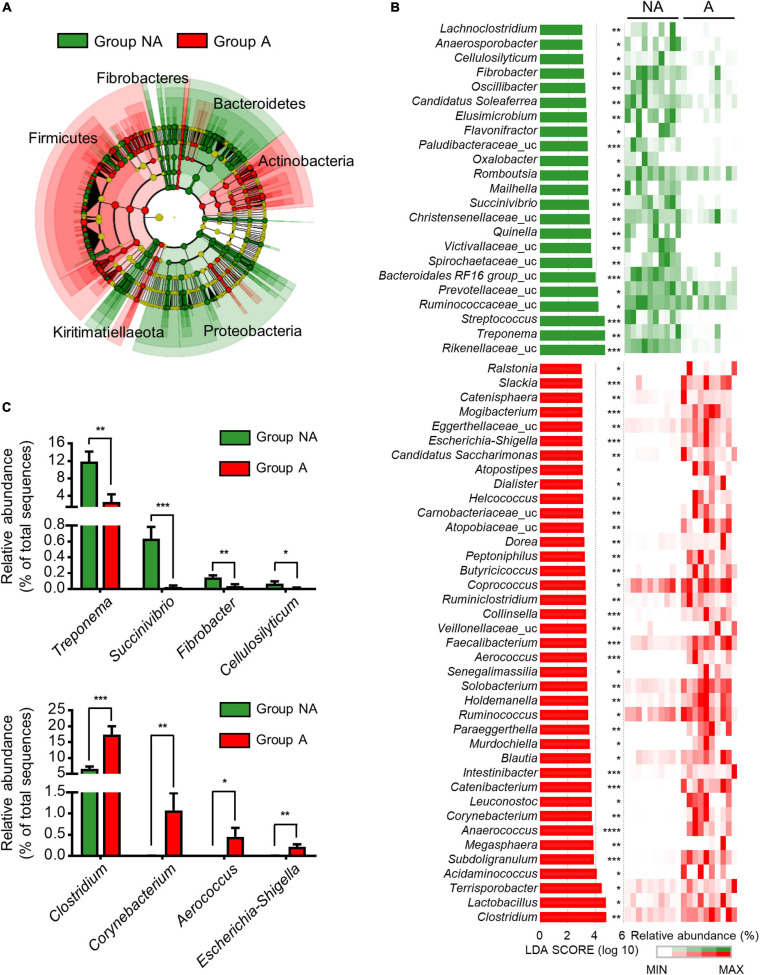
Comparison of swine microbial communities between the two groups. (A) Phylogenetic cladogram from LEfSe analysis, depicting the taxonomic association between the microbiome communities of groups NA and A. Each node represents a specific taxonomic type. (B) The ranking of significantly different genera by LEfSe method was revealed from the log LDA scores of the two groups. LEfSe was based on the non-parametric factorial Kruskal-Wallis sum-rank test followed by the Wilcoxon Signed-Rank test. Featured LDA scores >3.0 were plotted (p-value * < 0.05, ** < 0.01, *** < 0.001, **** < 0.0001). Uc: unclassified. (C) Bar plots illustrating selected features at the genus level. Values are expressed as mean ± SEM. Statistical analysis was performed using a one-tailed Student’s t-test (p-value * < 0.05, ** < 0.01, *** < 0.001).